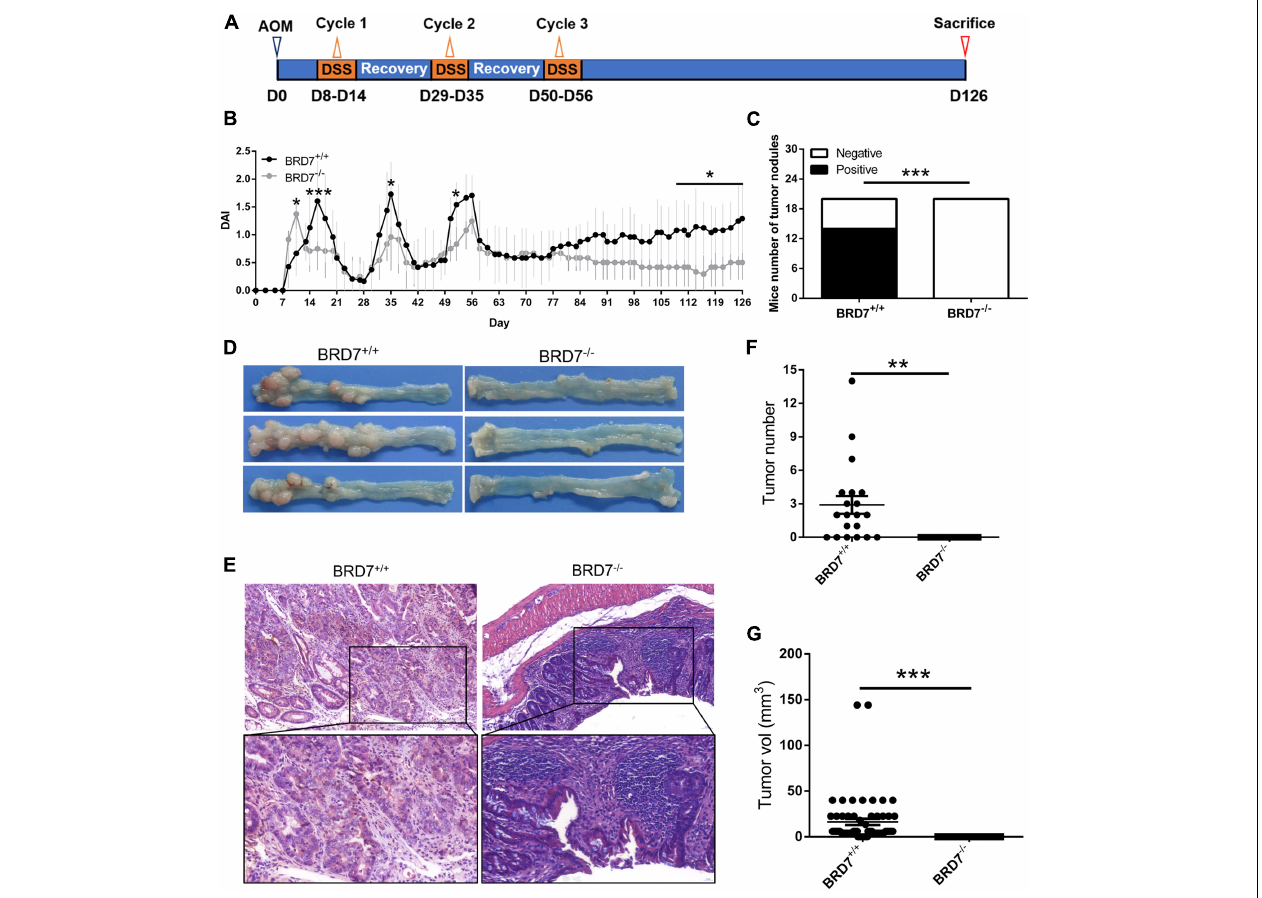
FIGURE 1 | BRD7 promotes azoxymethane/dextran sodium sulfate (AOM/DSS)-induced colitis-associated carcinogenesis in mice. (A) Schematic representation of the AOM/DSS-induced colitis-associated colorectal cancer (CRC) protocol. (B) disease activity index (DAI) score of BRD7 + / + and BRD7 − / − mice following AOM/DSS treatment, n = 20. (C) The number of BRD7 + / + and BRD7 − / − mice harboring tumor nodules. (D) Representative images of the colorectum of BRD7 + / + and BRD7 − / − mice on day 126. (E) Hematoxylin and eosin (H&E) staining of colorectal tissues of BRD7 + / + and BRD7 − / − mice. Images in the top panel were representative of H&E staining. Scale bar: 50 µ m. Images in the bottom panel were magnified from the black box area in the images in the top panel, respectively. Scale bar: 20 µ m. (F) The number and (G) volume of colorectal tumors in BRD7 + / + and BRD7 − / − mice. The results are presented as the mean ± SD. * P < 0.05, ** P < 0.01, *** P <